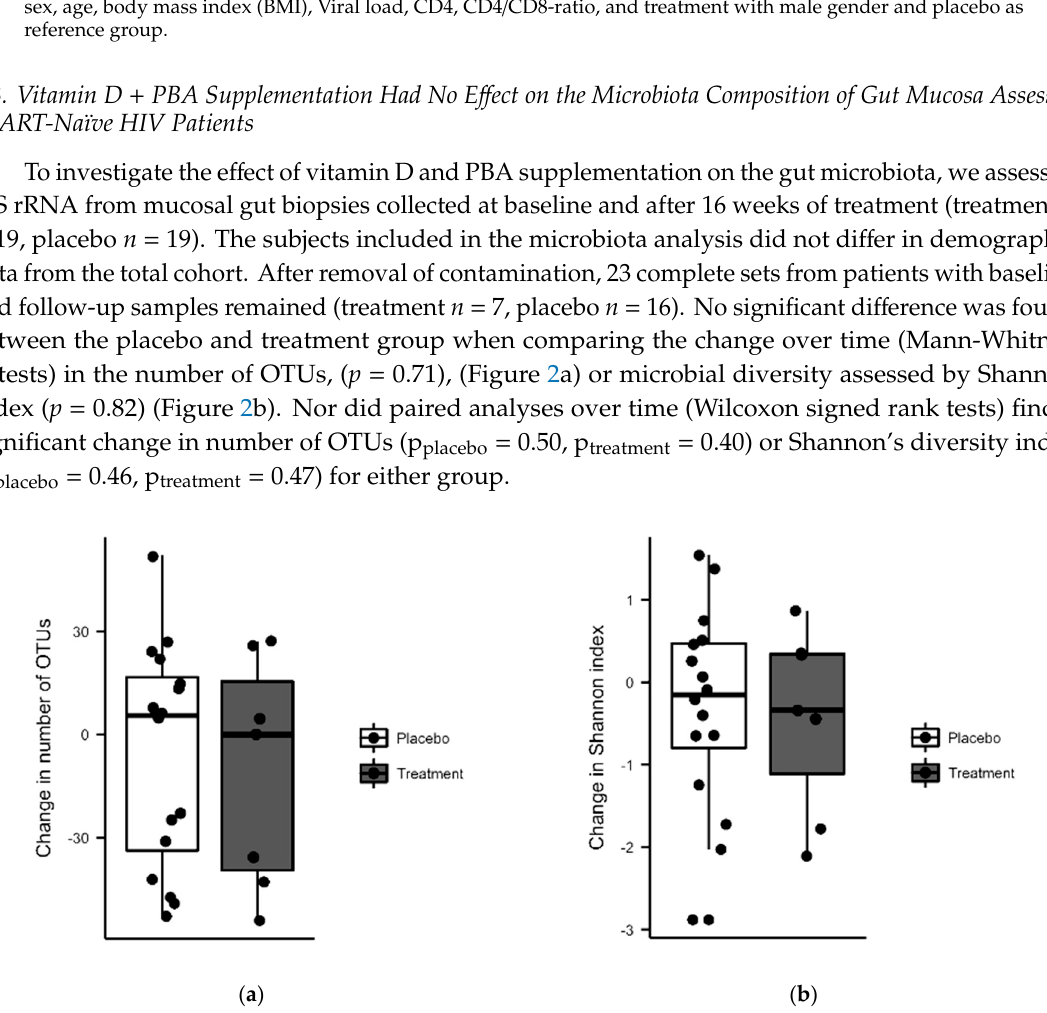
Table 3. Di ff erences in outcomes between placebo and treatment arm.